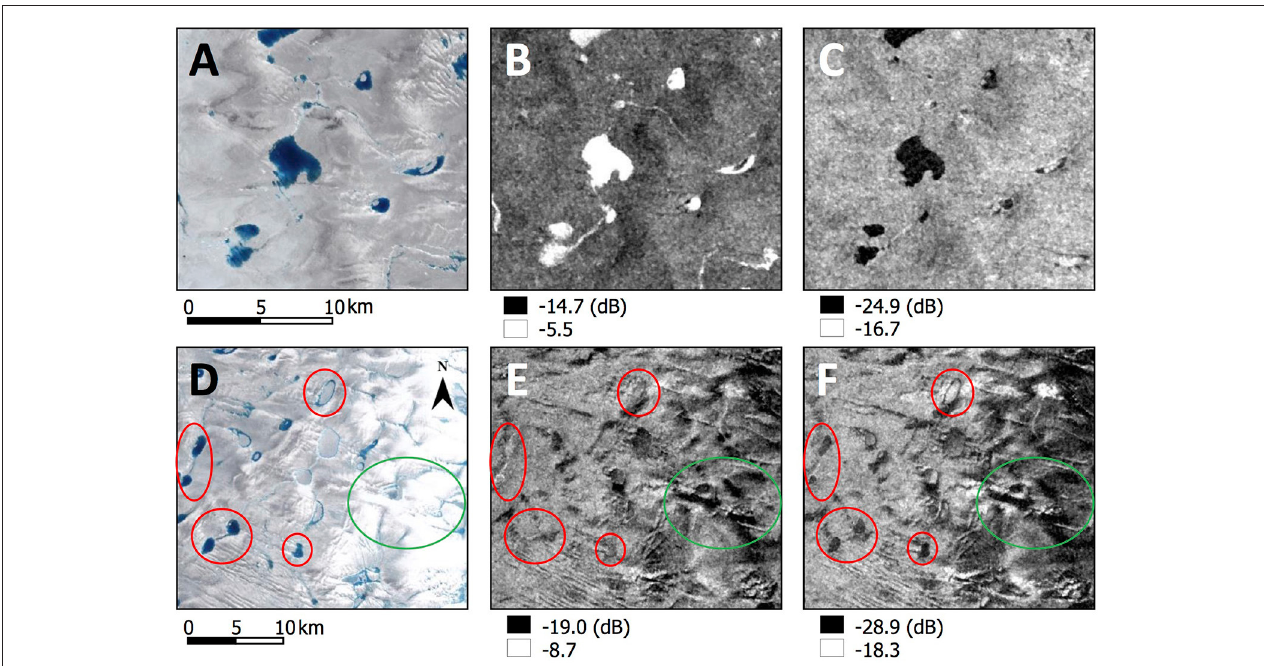
FIGURE 8 | Examples of where the Sentinel-1 lake detection method could not accurately depict lakes; Landsat false-color images are shown from day 196 (2015) (A) and day 189 (2015) (D) for reference, with the Sentinel-1 HH polarization backscatter image (B,E) and the HV polarization image (C,F) . Locations within the study region are shown in Figure 1 . Subsets (B,C) were imaged on day 201 (2015); (E,F) on day 191 (2015). Subsets (A–C) display lakes that unexpectedly produce very high backscatter values in the HH polarization (B) but typical low backscatter values in the HV polarization (C) . Subsets (D–F) display lakes (red circles) that are undetectable in the HH polarization (E) despite being visible in the Landsat (D) and HV polarization (F) , as well as areas of very low backscatter (green circles) where no water is visible in the Landsat imagery.